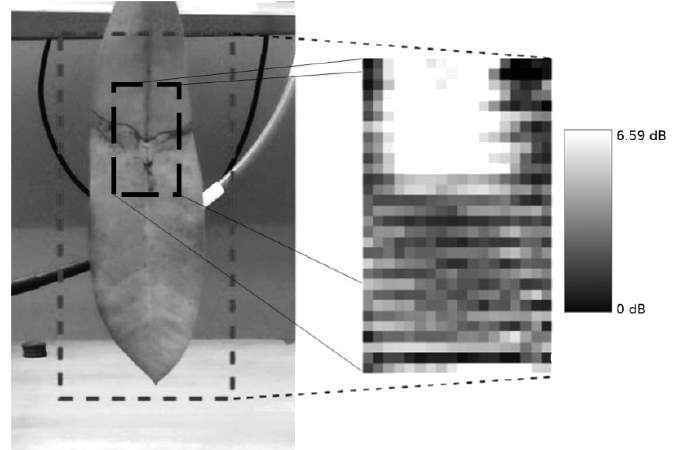
Figure 10. Test results with a half-brown leaf [6].